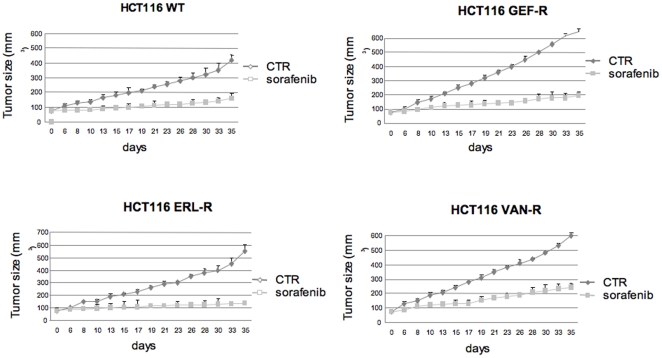
Antitumor activity of the sorafenib in parental and TKI-resistant HCT116 xenografts.A, Parental (WT) HCT116 cancer cells; B, GEF-R HCT116 cancer cells; C, VAN-R HCT116 cancer cells; D, HCT116 cancer cells. Athymic nude mice were injected subcutaneously into the dorsal flank with 107 cancer cells. After 7 to 10 days (average tumor size, 75 mm3), mice were treated as indicated in Materials and Methods for 5 weeks. Each treatment group consisted of 8 mice. Data represent the average (±SD). Student's t test was used to compare tumor sizes among different treatment groups at day 35 following the start of treatment. A, HCT116 WT: sorafenib versus control (two-sided p<0.001); B, HCT116: sorafenib versus control (two-sided p<0.001). C, HCT116 VAN-R: sorafenib versus control (two-sided p<0.001); D, HCT116 ERL-R: sorafenib versus control (two-sided p<0.001).